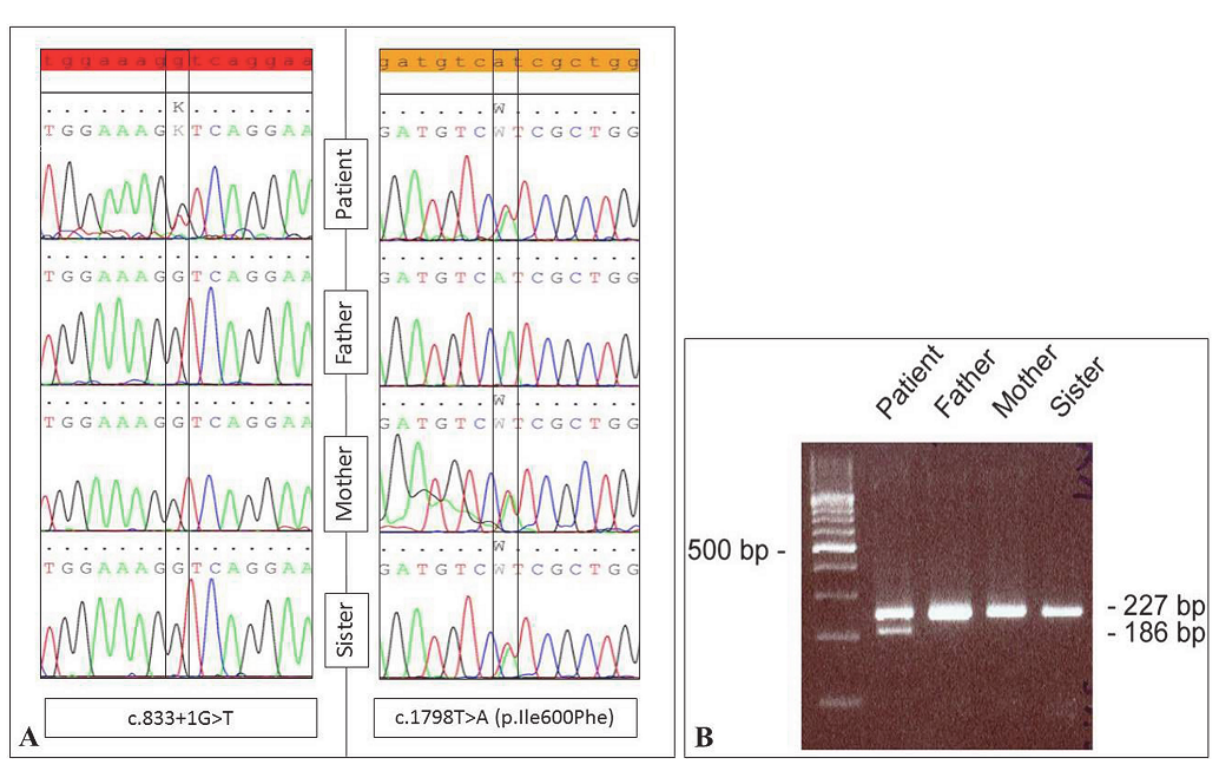
Fig. 2. Family analysis. (A) Mutations found in the index patient and his first-degree relatives. (B) Detection of the c.833+1G>T mutation using PCR- Hpy 8I restriction fragment length polymorphism